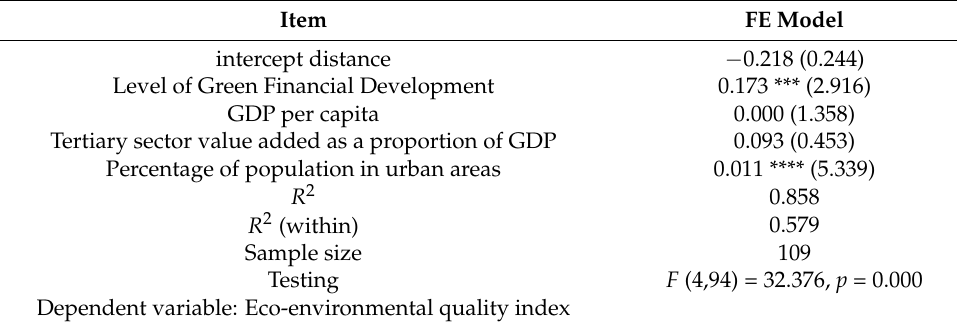
Table 9. Summary of panel regression